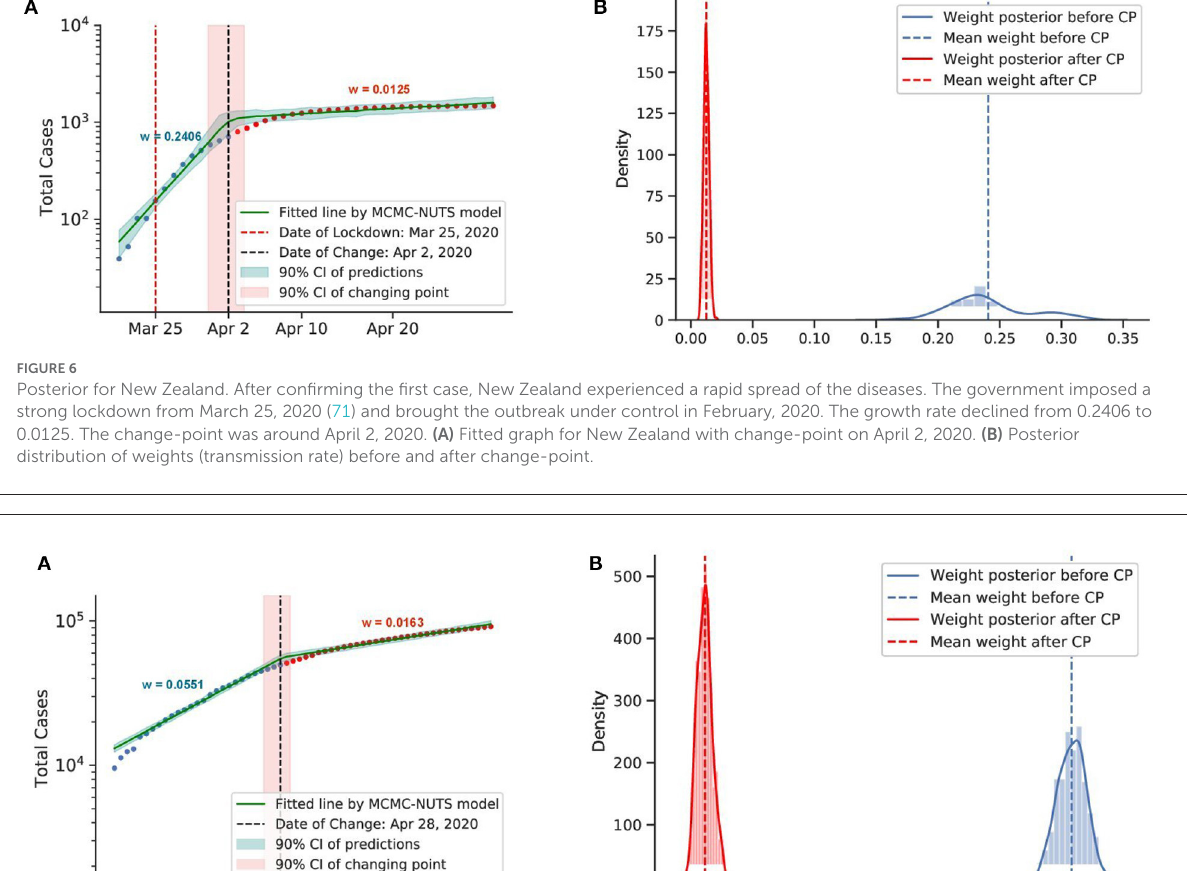
Our model shows that the policy took its effect around February 8, 2020, with a 98% reduction in the transmission